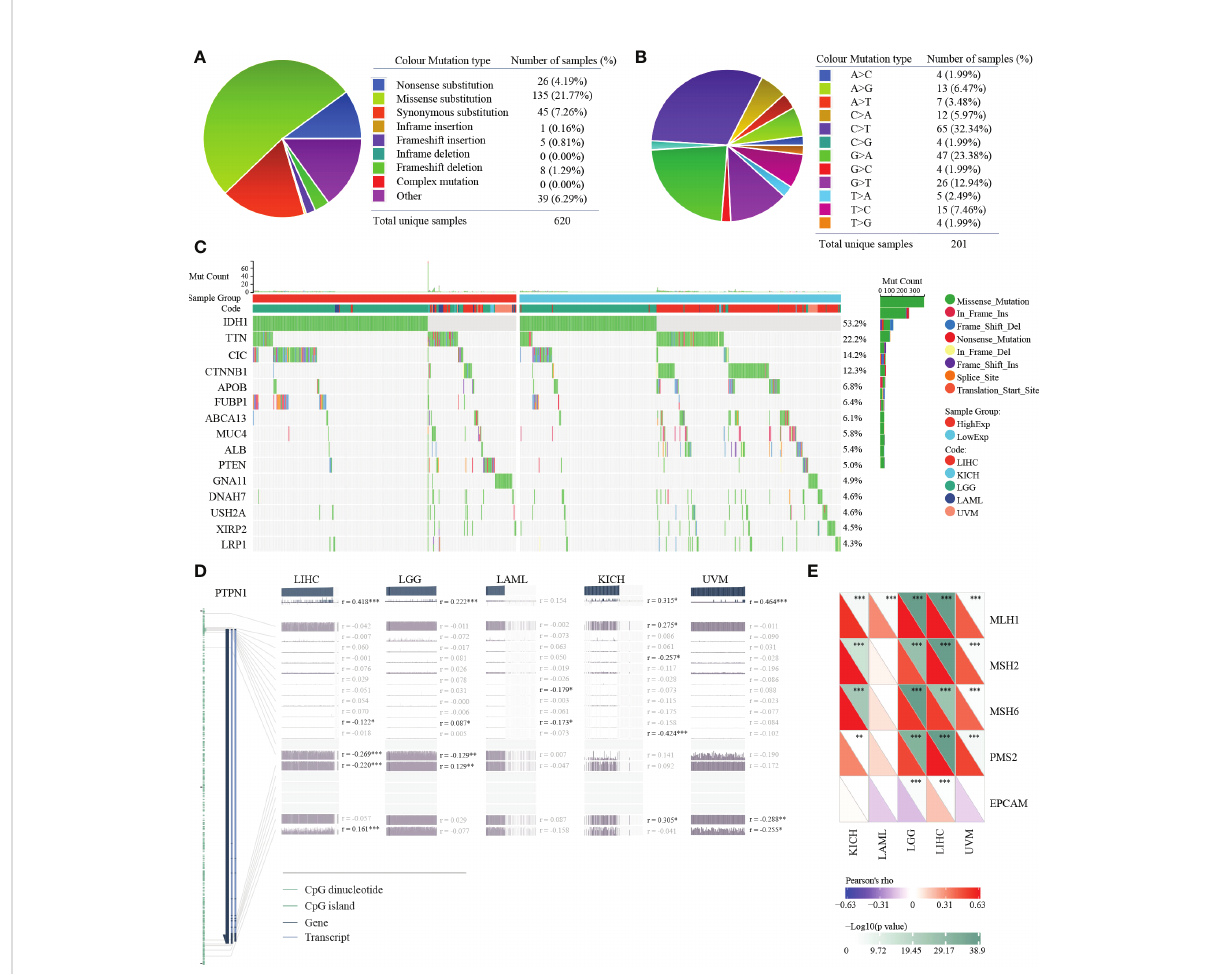
FIGURE 4 Mutation and methylation landscapes of PTP1B in cancers. (A, B) The summary (A) and substitution (B) mutation distribution analysis of PTP1B by COSMIC. (C) Mutation landscape of PTP1B in patients with LIHC, KIHC, LGG, LAML and UVM. (D) Methylation landscape of PTP1B in patients with LIHC, KIHC, LGG, LAML and UVM. (E) The correlation of PTP1B expression and methylation related genes (MLH1, MSH2, MSH6, PMS2 and EPCAM) in LIHC, KIHC, LGG, LAML and UVM. *p < 0.05; **p < 0.01; ***p <